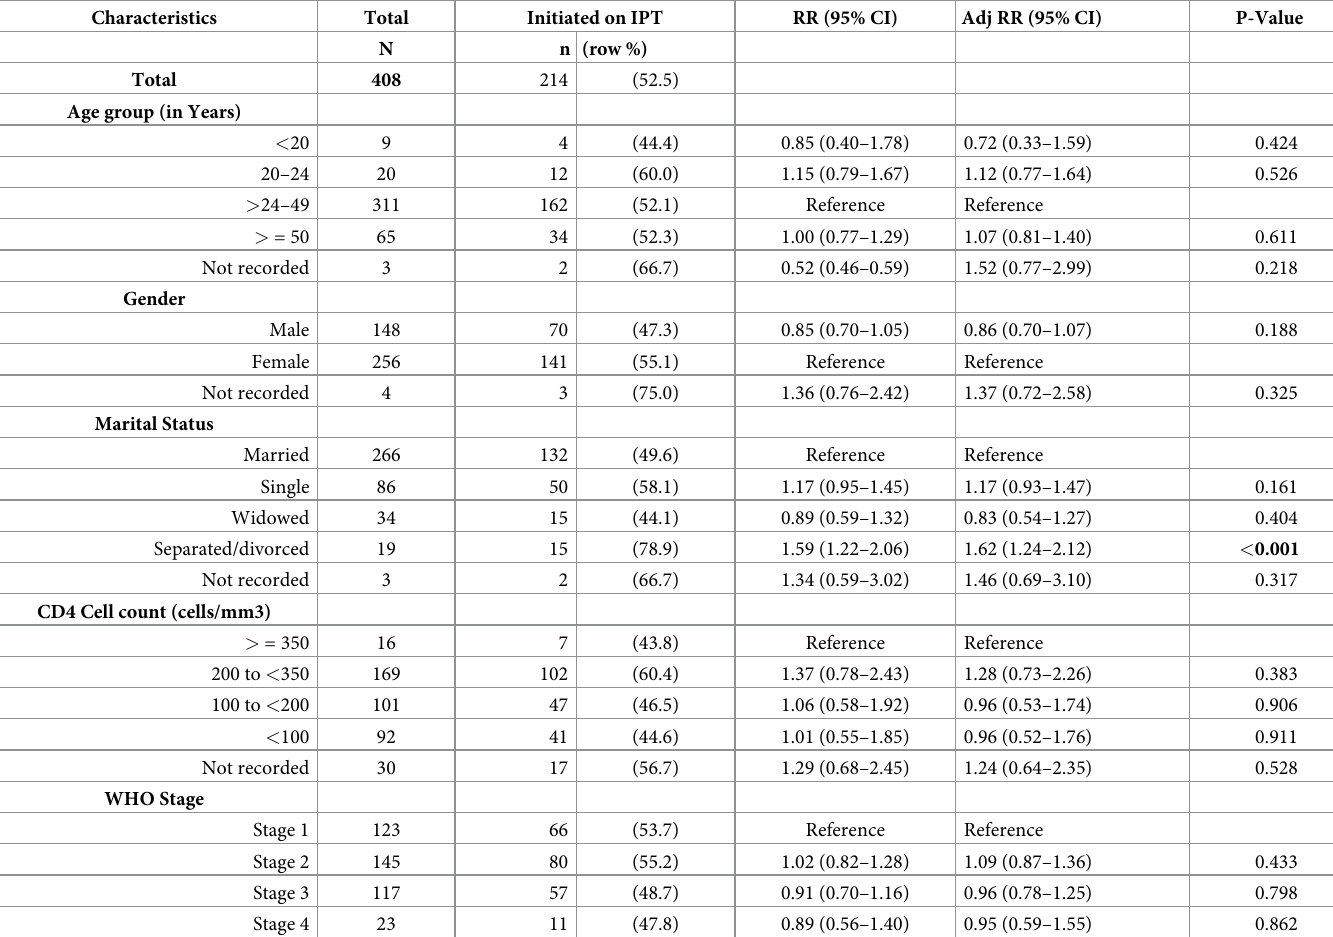
Table 2. Characteristics associated with IPT initiation in PLHIV who were initiated on ART in Bulawayo, Zimbabwe from October 2013 to March 2014. Characteristics